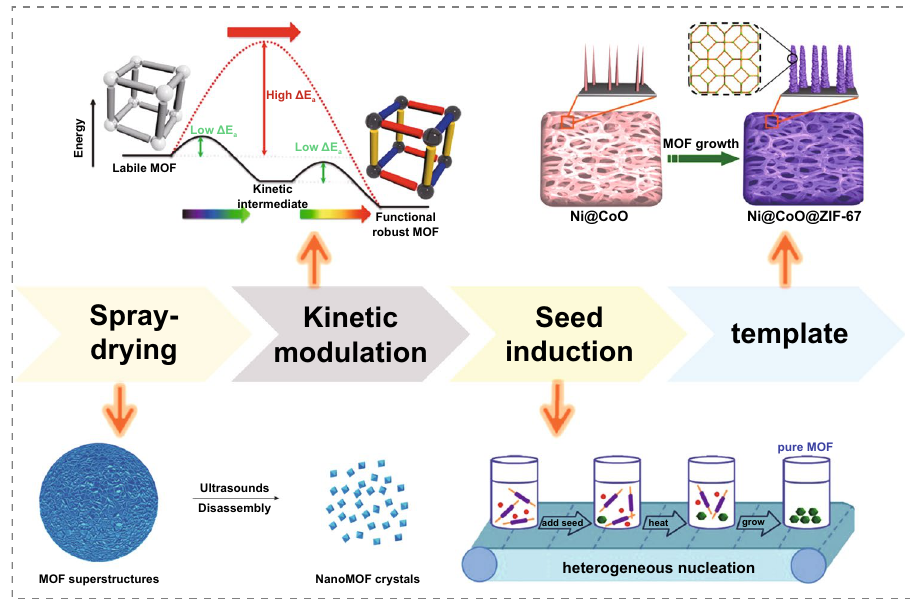
Fig. 4 Diagram of emerging preparation methods. Reprinted with permission from Ref. [73–76]. Copyright @2013 Nature Publishing Group, @ 2017 American Chemical Society, @ 2016 American Chemical Society, @ 2018 Springer Science Business